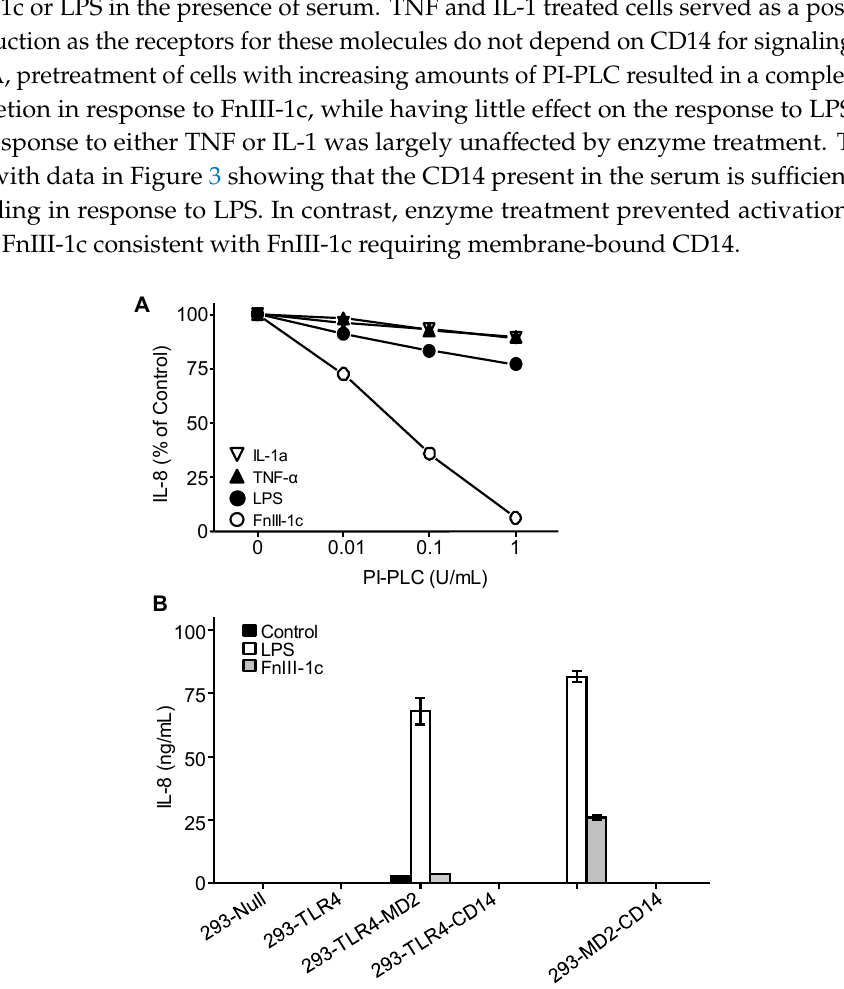
Figure 4. Effect of soluble and membrane CD14 on LPS and FnIII-1c-induced IL-8 expression. ( A ) Monolayers of human dermal fibroblasts were pre-incubated for 90 min with various concentrations of PI-PLC in 10% FBS/DMEM. Cells were then treated for 4 hours with IL-1 α (50 ng/mL), LPS (100 ng/mL), FnIII-1c (10 µM), or TNF- α (50 ng/mL) in the continuing presence of PI-PLC in 10% FBS/DMEM. Cells which were not treated with PI-PLC were set as control (100%) ( B ) HEK-293 cells engineered to express the designated components of theTLR4 receptor complex were incubated with LPS (1 µg/mL) or FnIII-1c (20 µM) in 10% FBS-DMEM for 24 hours. Cells receiving only 10% FBS-DMEM served as control. IL-8 concentration in conditioned medium was measured by ELISA. The data represent the mean ± S.E. of triplicate assays from two separate experiments.